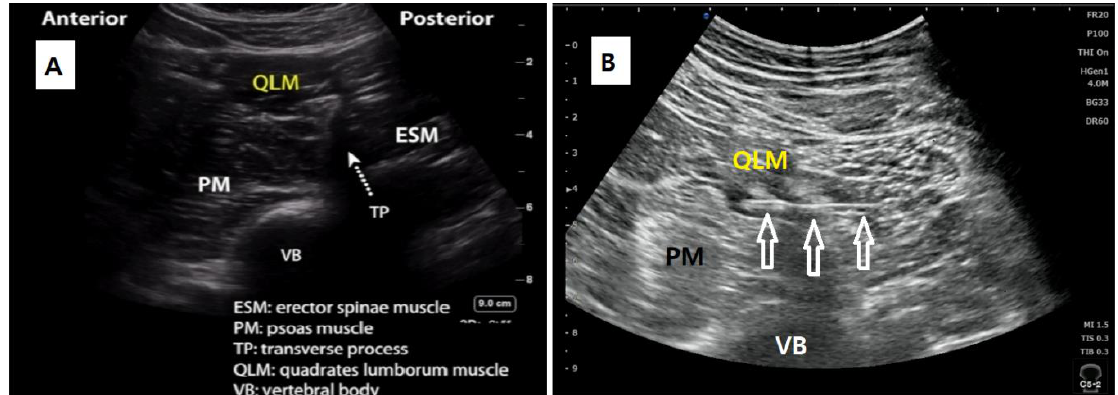
Figure 1. Schematic illustration of the procedure of QLB. ( A ) The Shamrock sign; ( B ) ultrasound image of anterior QLB with displaying needle trajectory (white arrows display needle trajectory). QLM, quadratus lumborum muscle; PM, psoas muscle; TP, transverse process; ESM, erector spinae muscle; VB, vertebral body.